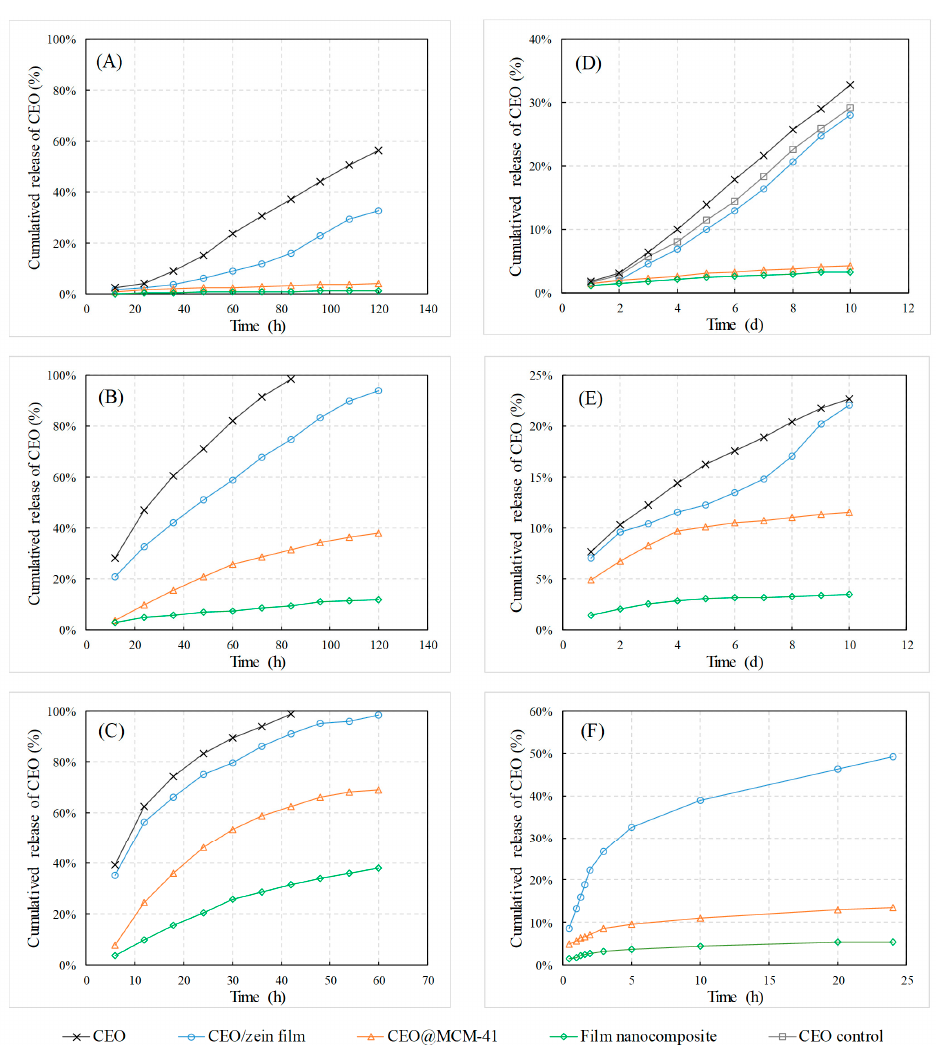
Figure 5. Release behavior of CEO from CEO / zein film, CEO@MCM-41 and film nanocomposite at di ff erent conditions. Including: at a high temperature of ( A ) 40 ◦ C, ( B ) 60 ◦ C and ( C ) 80 ◦ C, ( D ) under continuous illumination at room temperature (the control CEO sample without illumination), ( E ) under high humidity of 80% and room temperature, and ( F ) in neutral PBS